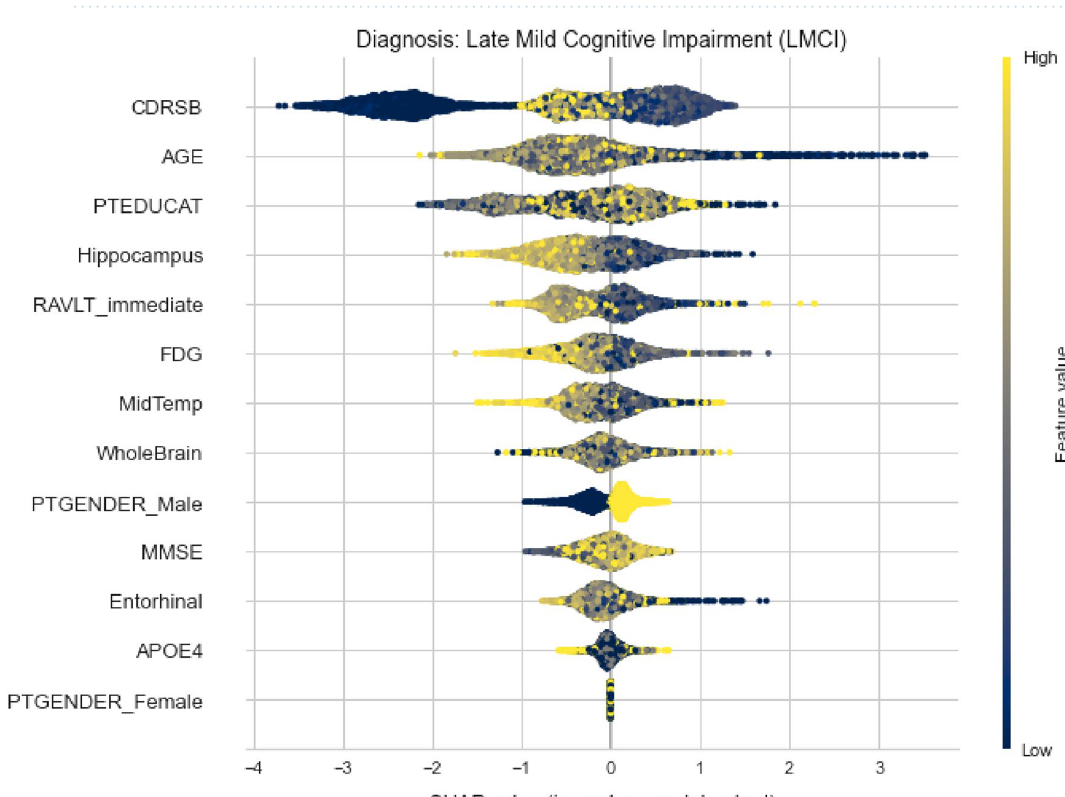
Figure 13. Variables importance plot for LMCI diagnosis.